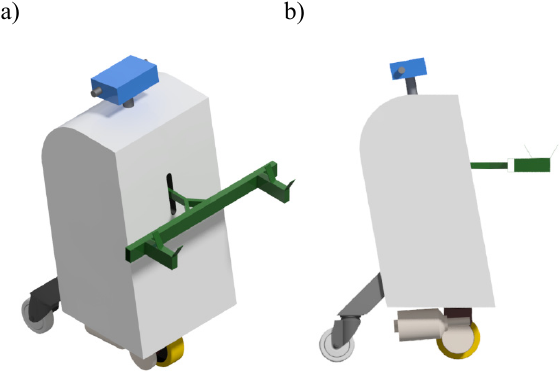
Figure 1. Isometric (a) and side views (b) of solution A.